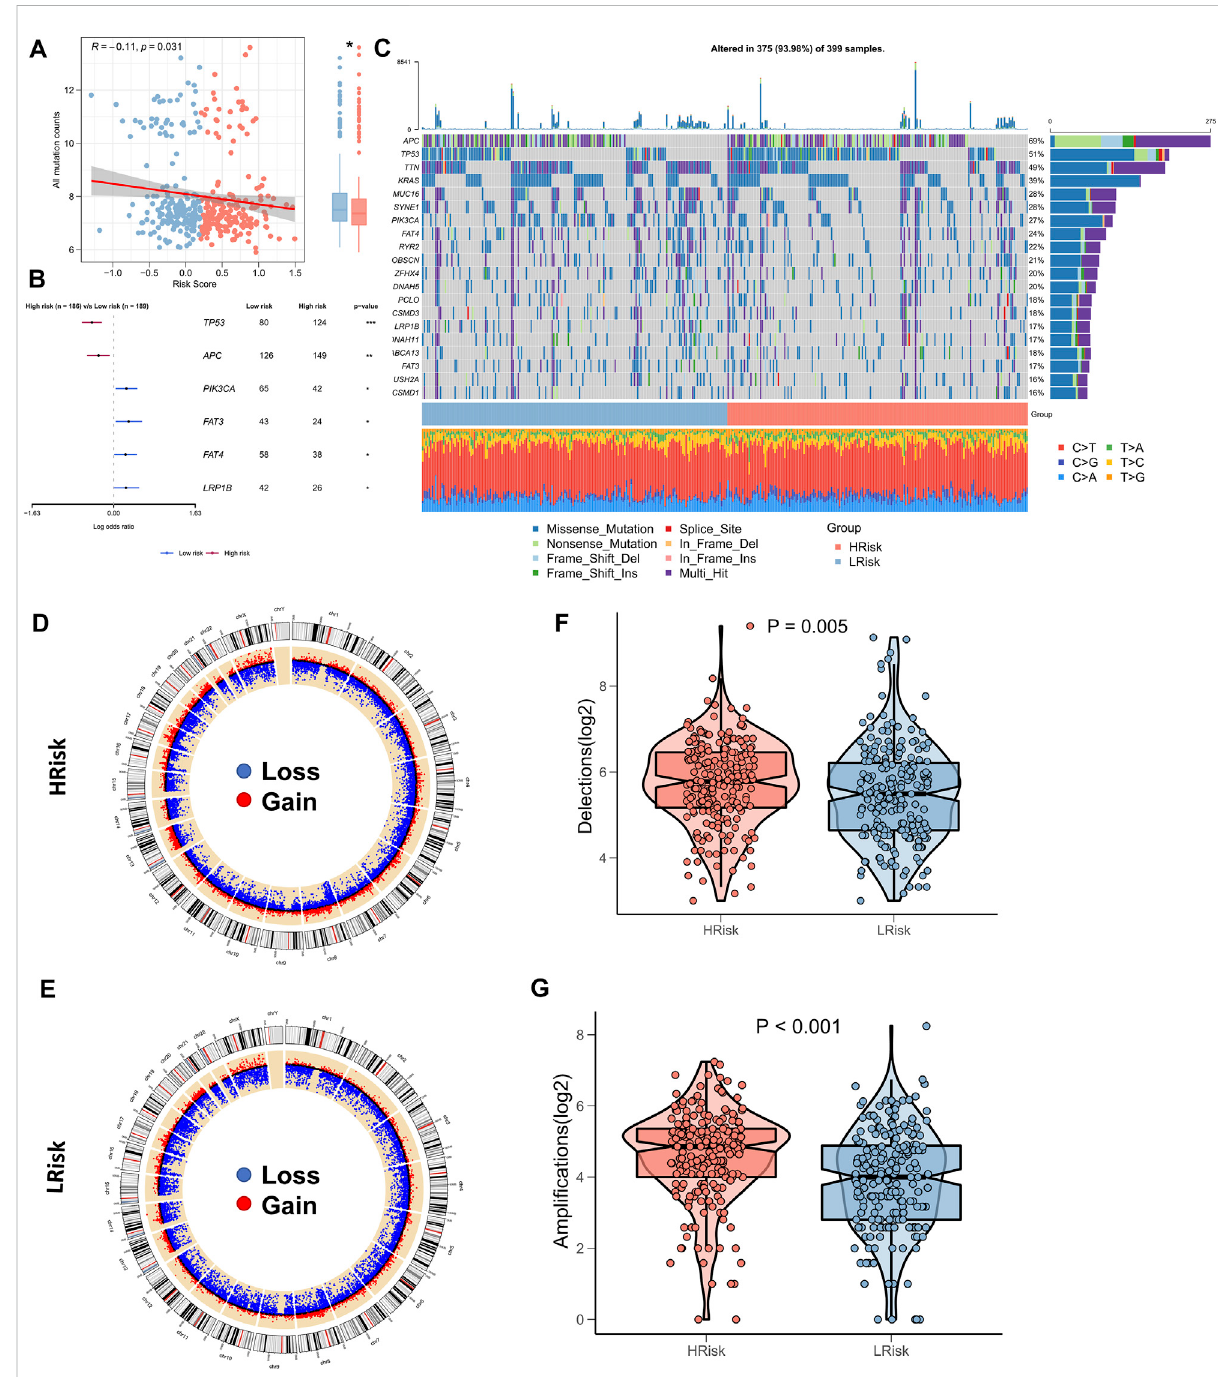
FIGURE 6 Landscape of genomic variations for NRG-related risk model. (A) Correlation between RiskScore and TMB; (B) . Forest plot showing genes with signi fi cant mutationaldifferences between the high-risk and low-risk groups; (C) . Oncoplotshowing signi fi cantly mutatedgenes between thehigh- riskandlow-riskgroups; (D) .CircleplotshowingtheCNVlandscapeinthehigh-riskgroup; (E) .CircleplotshowingtheCNVlandscapeinthelow-risk group; (F) .Boxplotshowingthedifferencesinthenumberofchromosomaldeletionsbetweenthehigh-riskandlow-riskgroups; (G) .Boxplots showing the differences in the number of chromosome ampli fi cations between the high-risk and low-risk